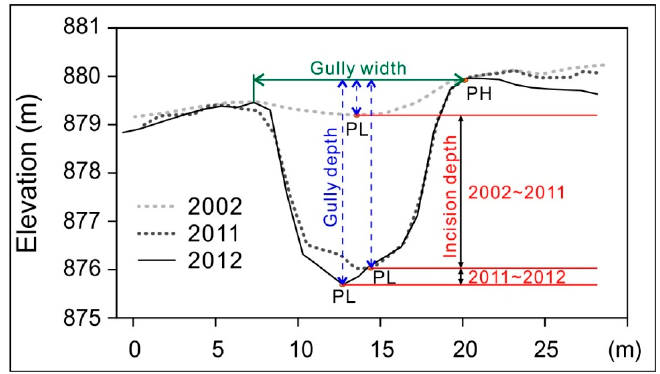
Figure 5. A schematic of the depth calculation for the incision of the gully sections.